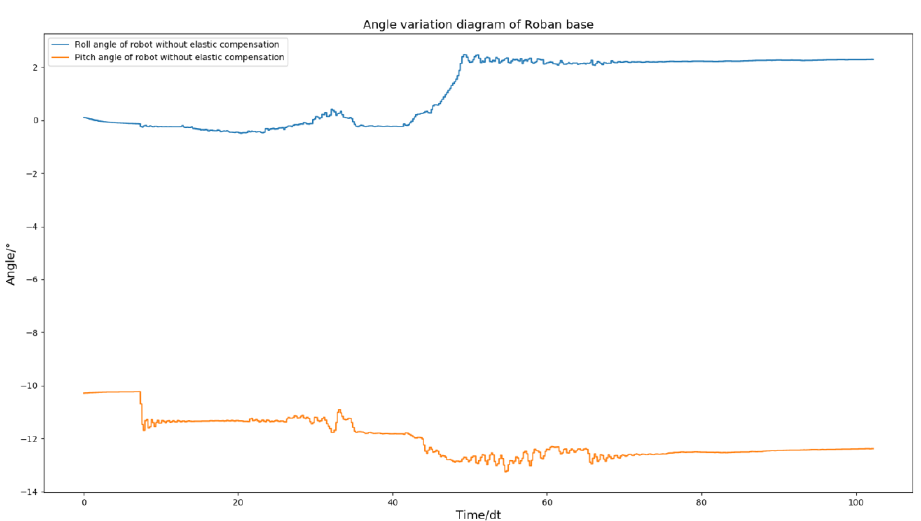
Figure 6. Roll angle and pitch angle change curve of Roban standing on a single leg under position control.